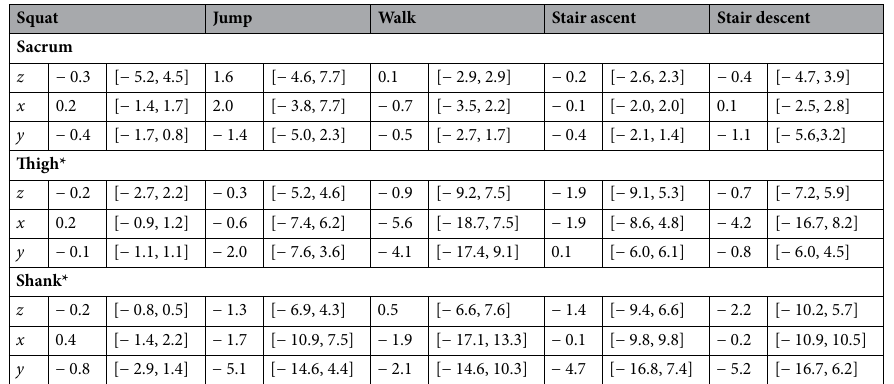
Table 1. Mean differences [95% CIs] for acceleration range values (m/s 2 ) between Xsens MTw and Xsens Dot. CI confidence interval. *Data presented for right limb.